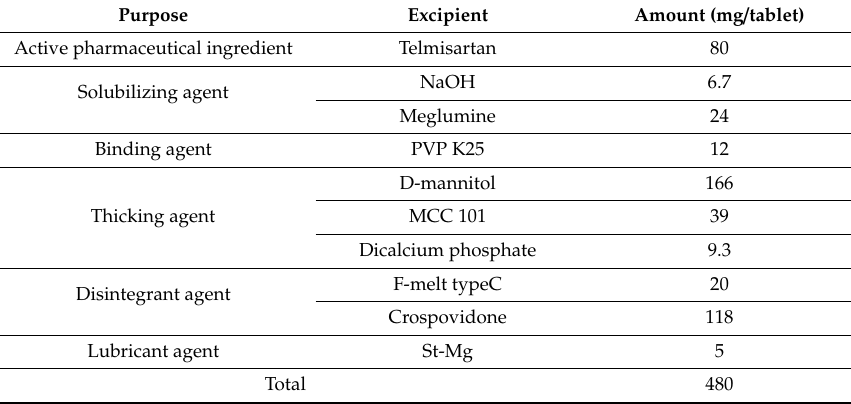
Table 1. Formulation of telmisartan